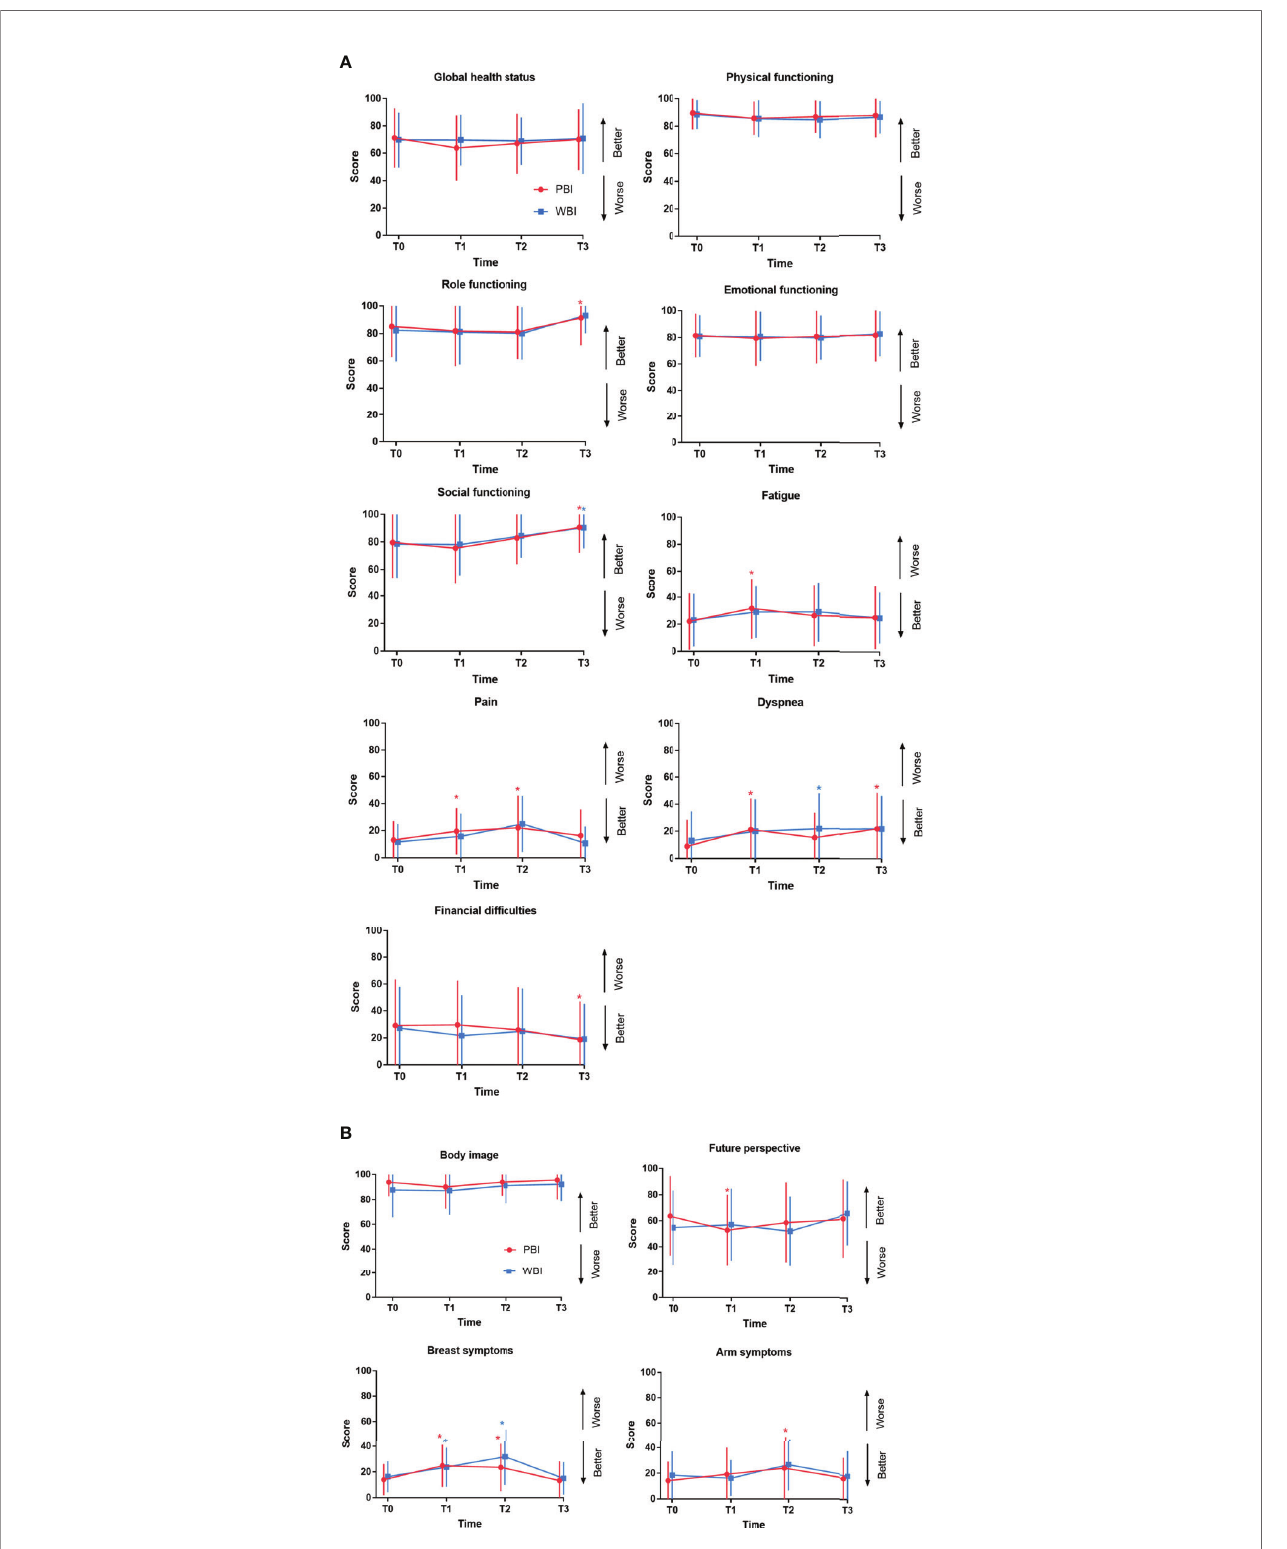
FIGURE 2 | Quality of life changes over time in the PBI and WBI arm determined using the QLQ-C30 (A) and QLQ-BR23 (B) questionnaires. These graphs show changes in the mean QoL scores over time for each domain. Error bars represent standard deviation (SD). *Time points at which differences from baseline were signi fi cant at P < 0.01 level. PBI, partial breast irradiation; WBI, whole-breast irradiation; QoL, quality of